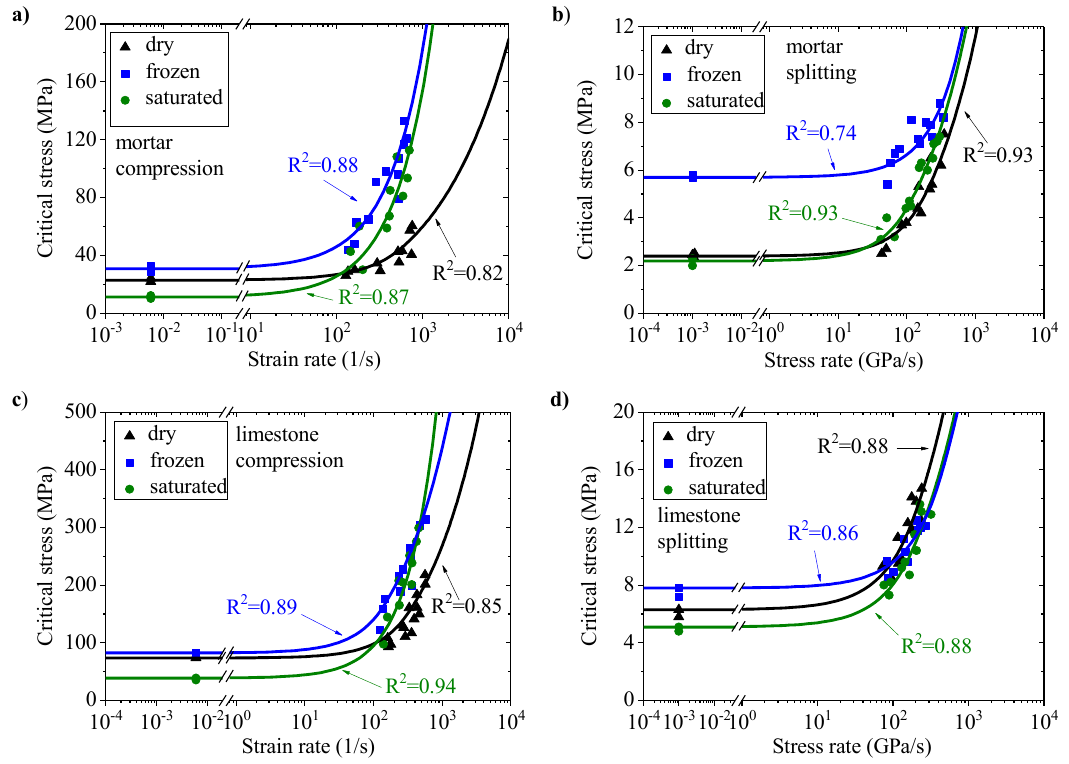
Figure 7. Critical failure stresses in mortar ( a , b ) and limestone ( c , d ) versus strain rate under compression ( a , c ) and stress rate under splitting ( b , d ). Curves are calculated by Equation (3). R 2 is the coefficients of determination. Table 1. Parameters of quasi-brittle materials: (cid:2026) (cid:3007)(cid:3020)(cid:3030)(cid:3042)(cid:3040)(cid:3043) is the quasi-static compression strength; (cid:2026) (cid:3007)(cid:3020)(cid:3046)(cid:3043) is the quasi-static splitting strength; (cid:2028) (cid:3007)(cid:3030)(cid:3042)(cid:3040)(cid:3043) is the incubation time of failure under compression; (cid:2028) (cid:3007)(cid:3046)(cid:3043) is the incubation time of failure under splitting. Mean (standard deviation).